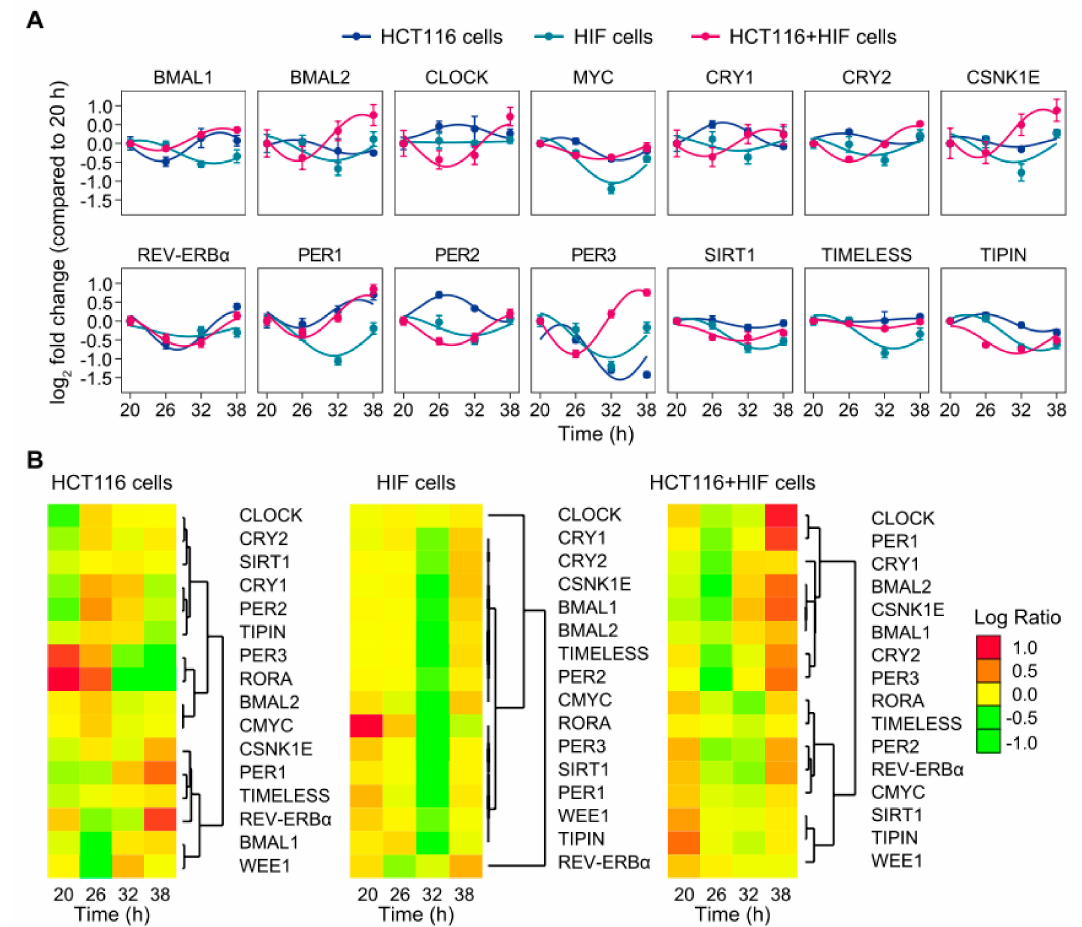
Figure 2. Co-culture of HCT116 and HIF cell lines alters the rhythmic expression of core-clock genes. ( A ) Time-series expression profiles of core-clock genes and putative circadian-regulated genes in HCT116 cells (dark blue), HIF cells (light blue), and a HCT116 + HIF co-culture (pink). A sine–cosine curve was fitted to the data using the model y = m + a × sin for the di ff erent conditions was chosen dependent on the period lengths observed in the long-term, real-time bioluminescence recording of BMAL1 promoter activity. ( B ) Hierarchical clustering analysis of sequential transcriptional changes of core-clock genes and clock-controlled genes. Colour code of heatmaps is